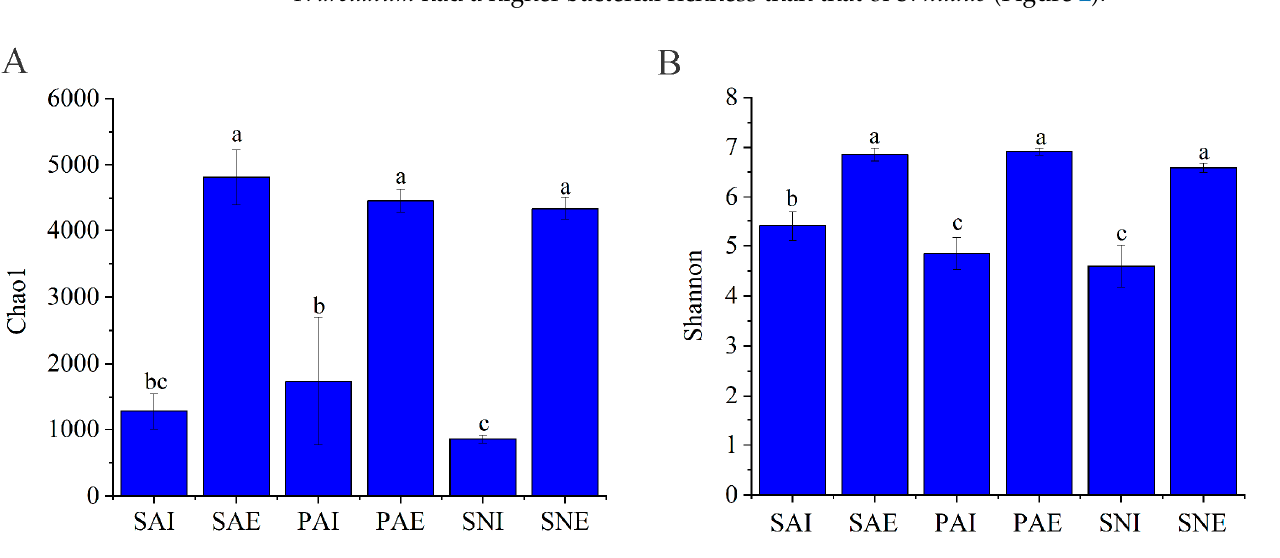
Figure 2. α -diversity of microbial communities in gut contents and surrounding sediments of S. australe, P. arcuatum, and S. nudus . ( A ) for Chao1 index, ( B ) for Shannon diversity index. The different letters indicate significant differences among samples ( p < 0.05). The gut contents and surrounding sediments of S. australe, P. arcuatum, and S. nudus are, respectively, marked as SAI, PAI, SNI, SAE, PAE, and SNE.